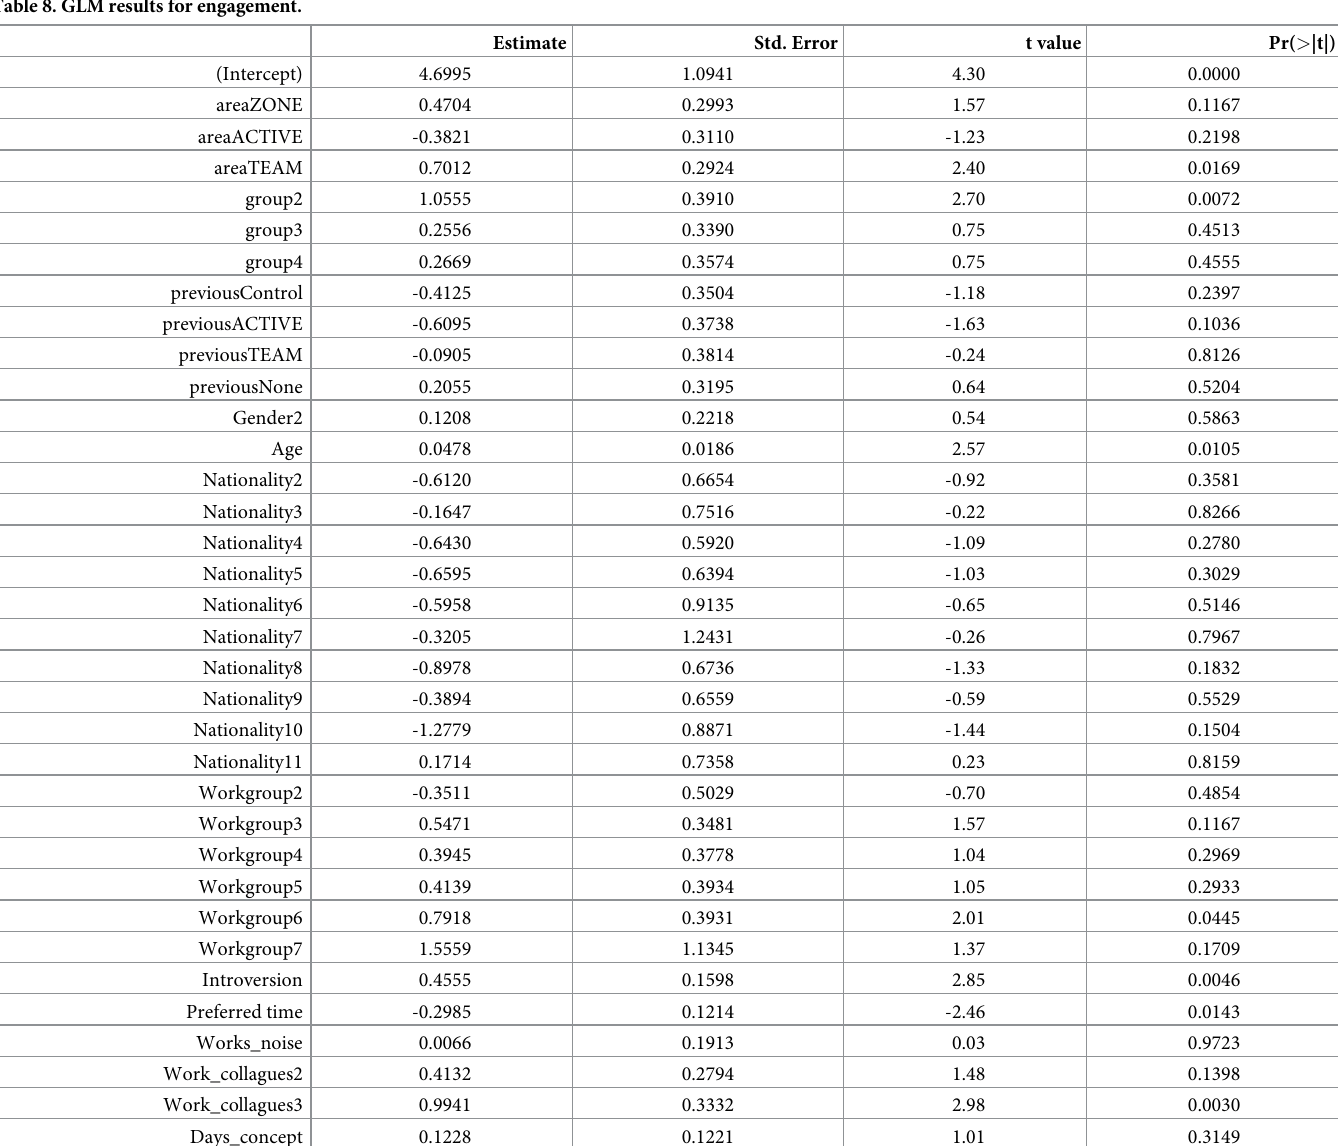
Table 8. GLM results for